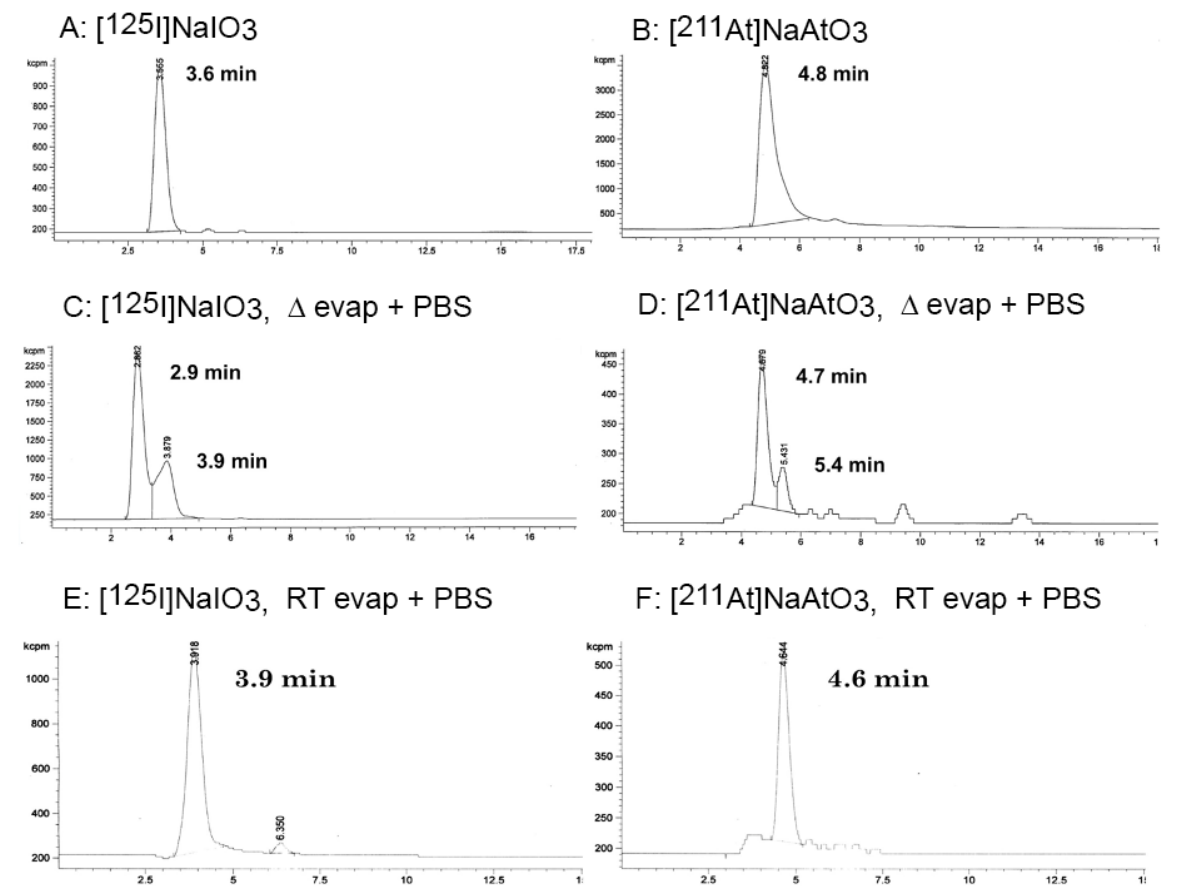
Figure 6. Radiochromatograms of reaction solutions and isolated products in the preparation of